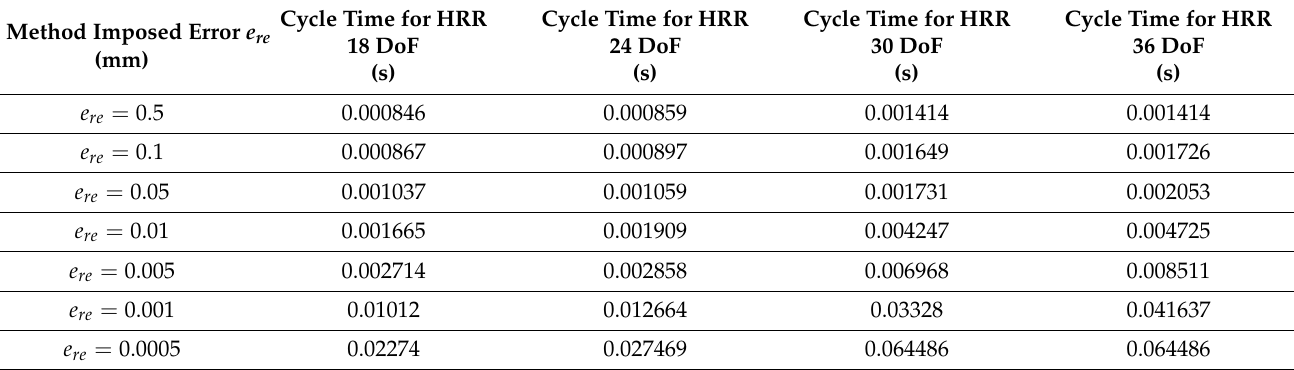
Table 4. Cycle time for robots with different DoFs and imposed values for e